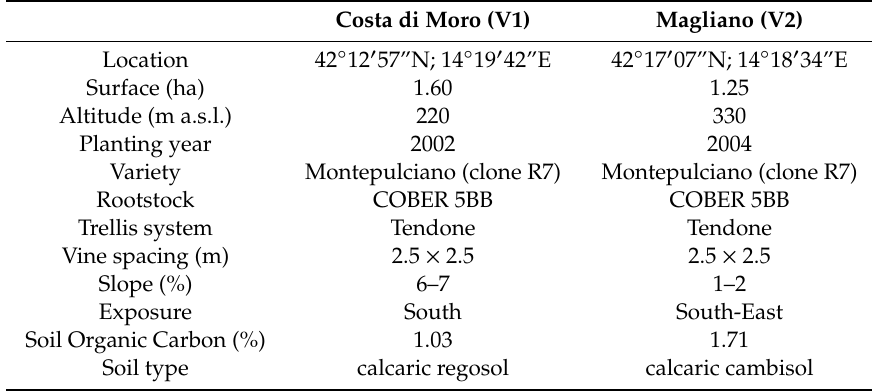
Table 1. Experimental